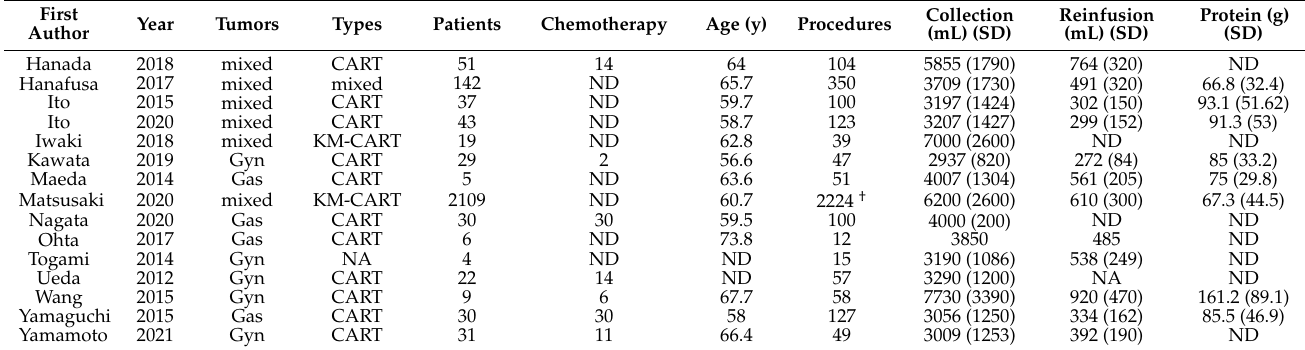
Table 1. Background and characteristics of studies included.